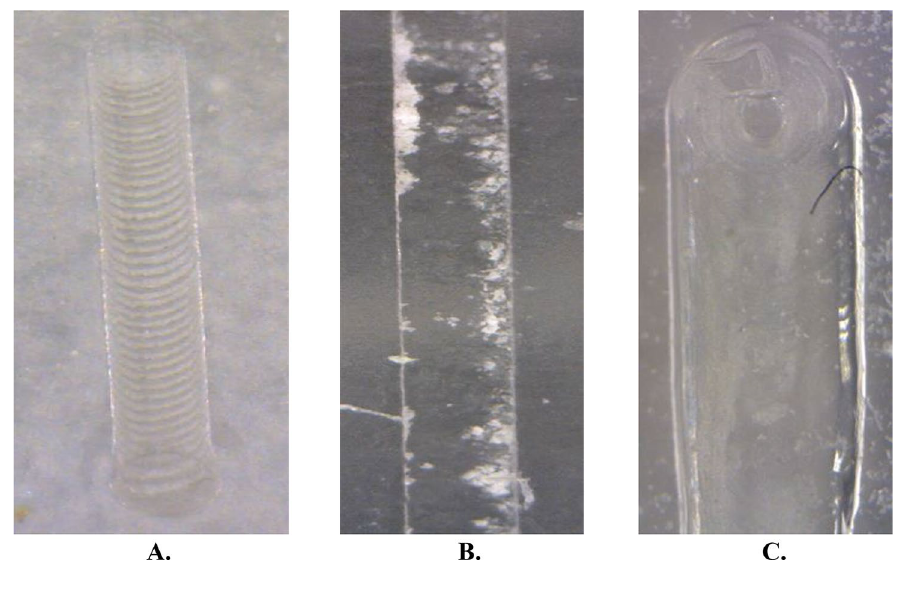
Fig. 19 Surface roughness profile of channels created in voltage conditions of 38 V, NaOH electrolyte solution concentration of 25%, feed rate of 0.6 mm/min and rotational speeds of a zero, b 5000 rpm and c 10,000